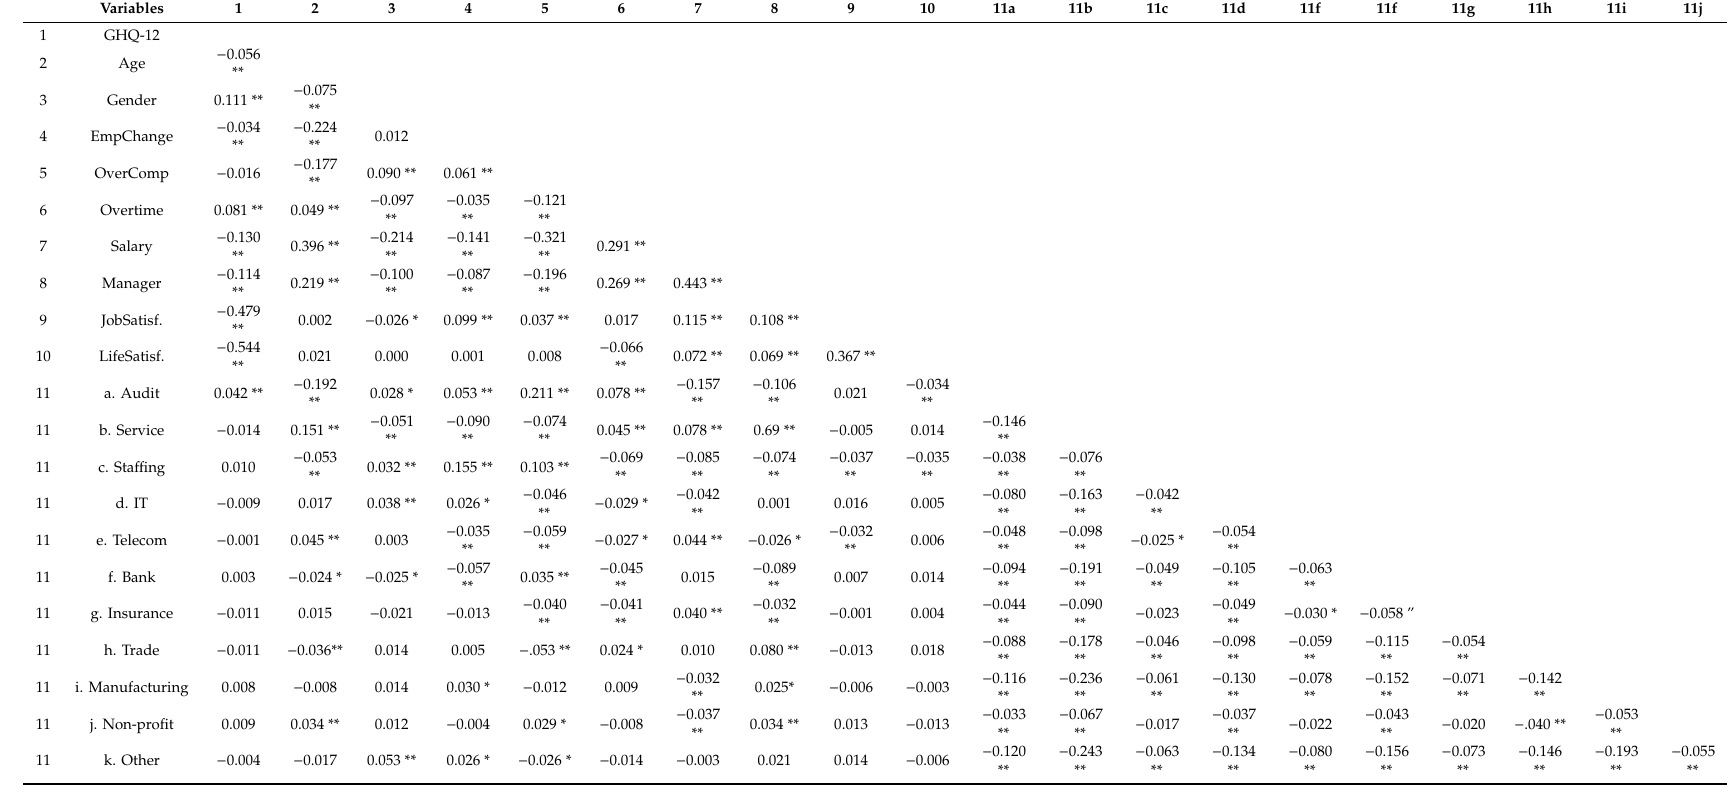
Table 2. Pearson correlation matrix ( n =